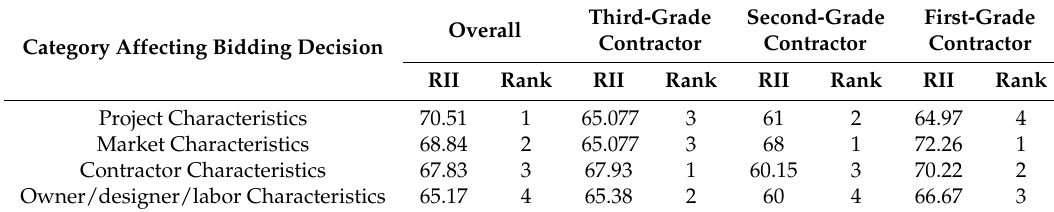
Table 3. Overall, third-grade, second-grade and first-grade contractors’ RII values and ranks of categories affecting bidding